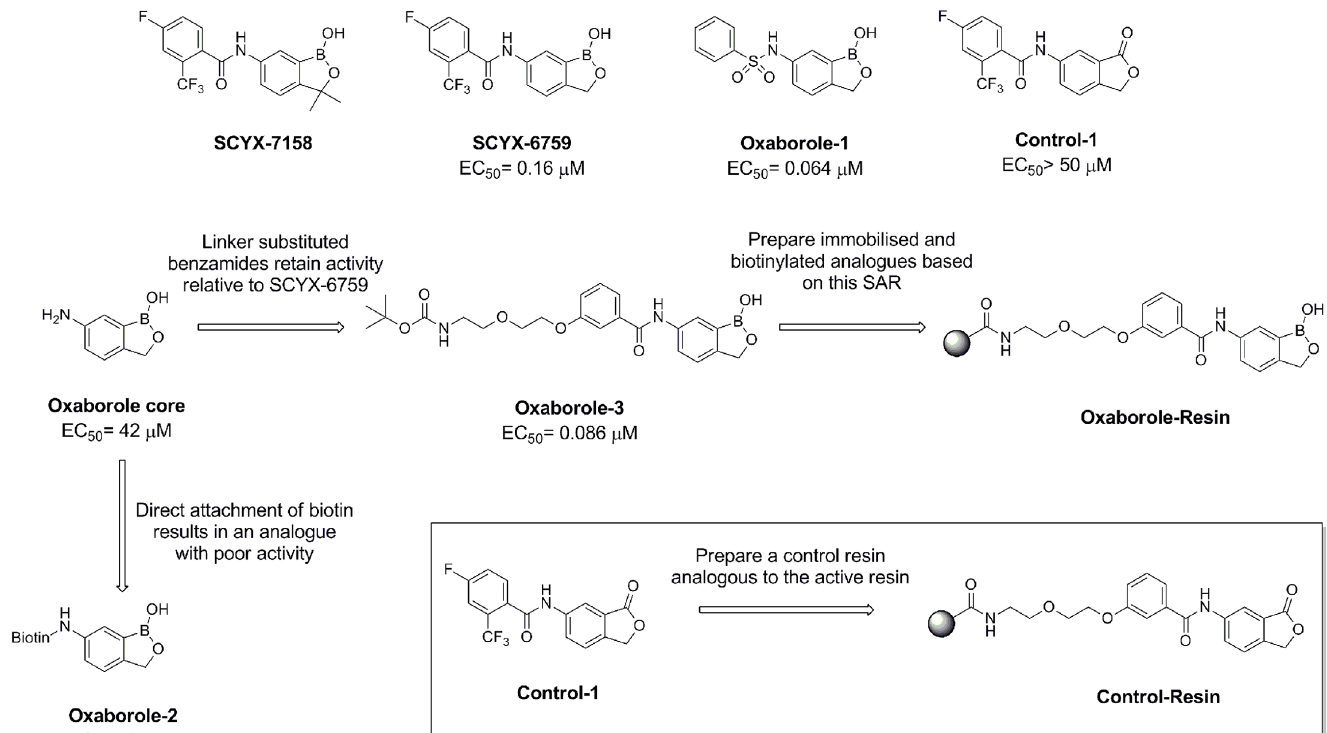
Fig 1. Structure of oxaboroles and affinity chromatography